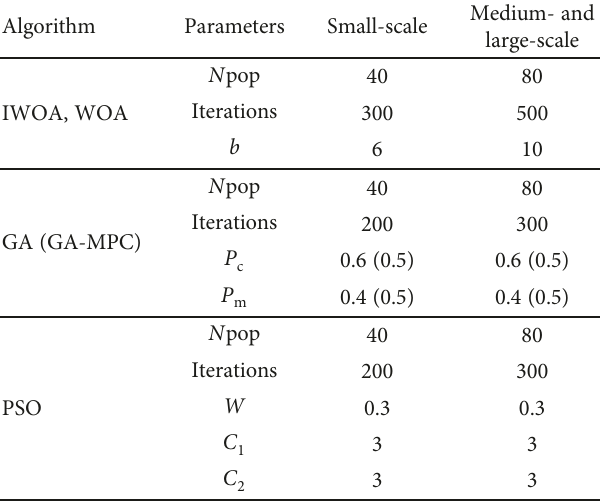
Table 3: Parameters of metaheuristic algorithms.